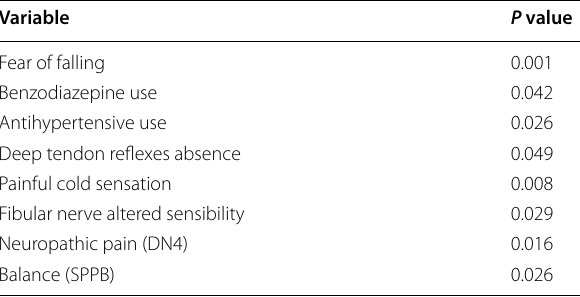
DAS-28 ESR , Disease Activity Score -28—erythrocyte sedimentation rate; HAQ, Health Assessment Score; DN4, Neuropathic Pain Questionnaire; SPPB, short physical performance